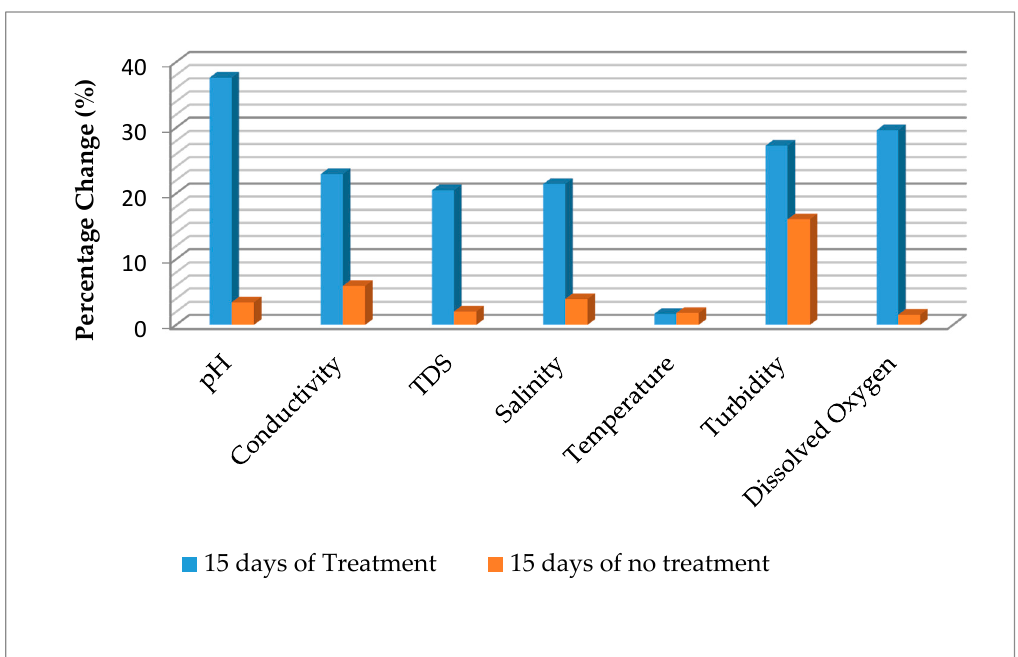
Figure 1. Percentage change in in-situ parameters of cassava mill effluents after 15 days.